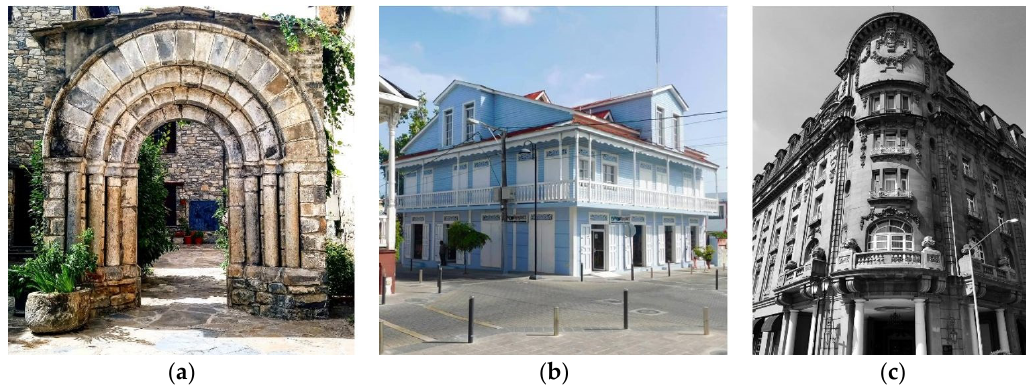
Figure 4. Architectural heritage pictures collected from #patrimonioarquitectonico in Instagram regarding color: ( a ) font, muntsa33; ( b ) font, achadasrd; ( c ) font, jslzrrz.